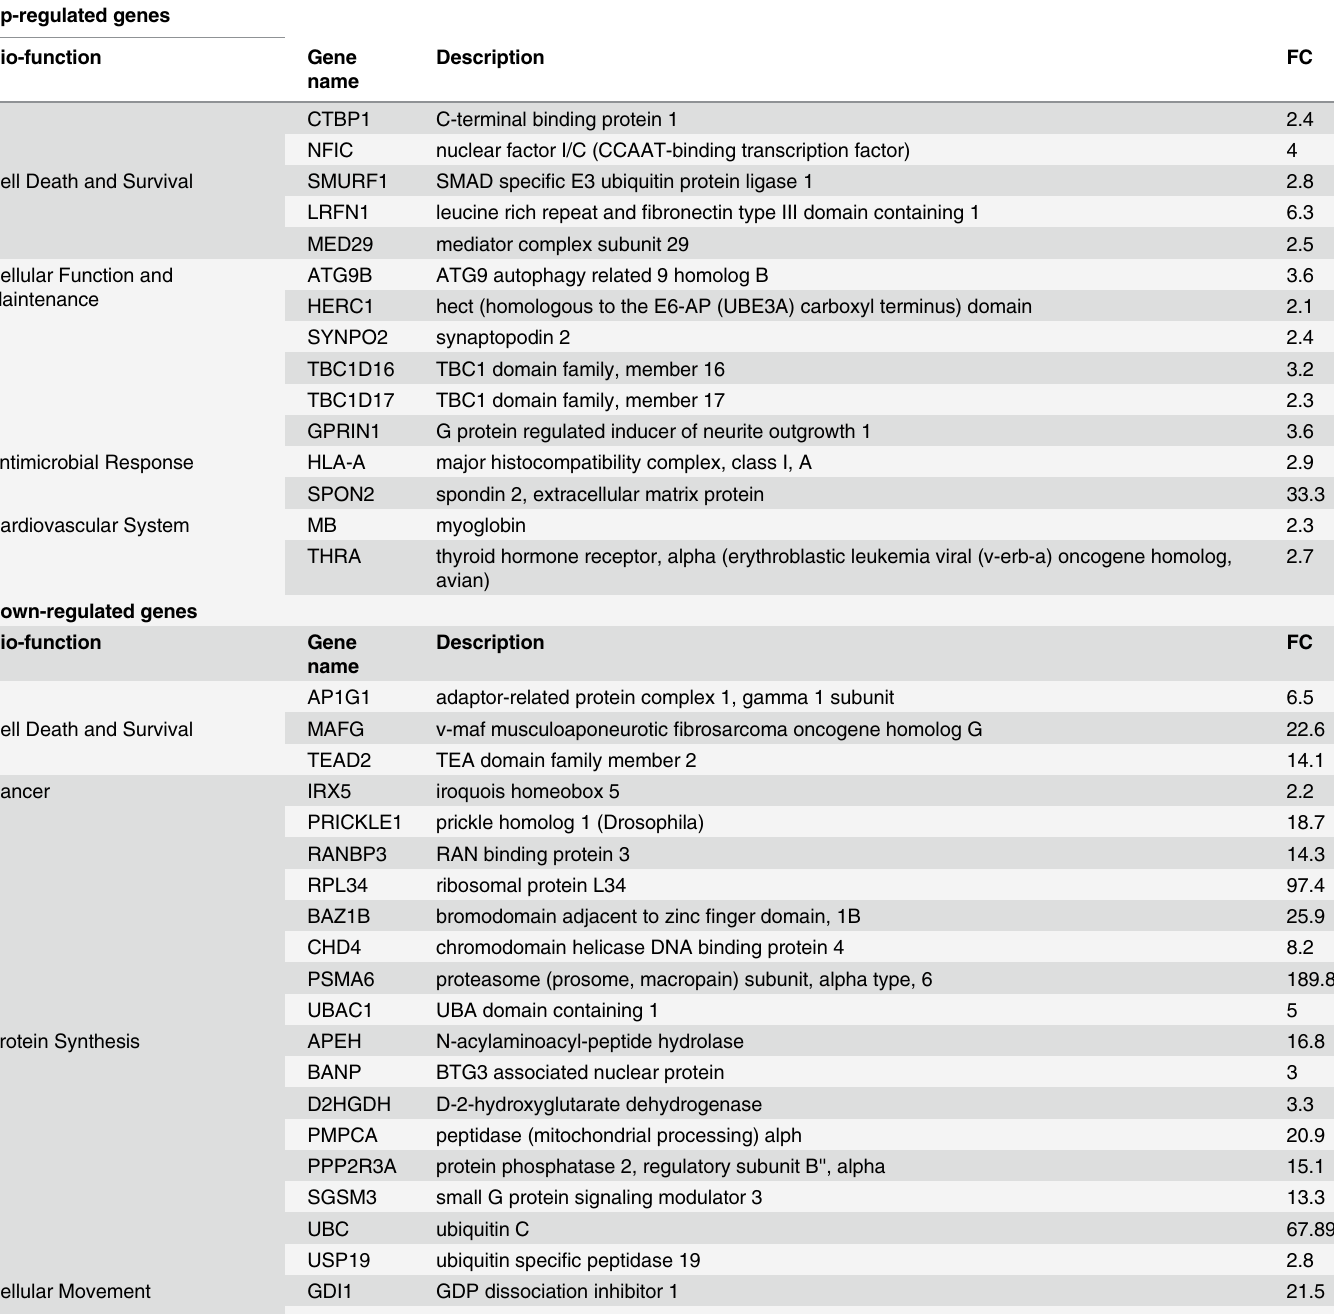
Table 7. Particular genes significantly differentially regulated in AFS compared to amniocytes.